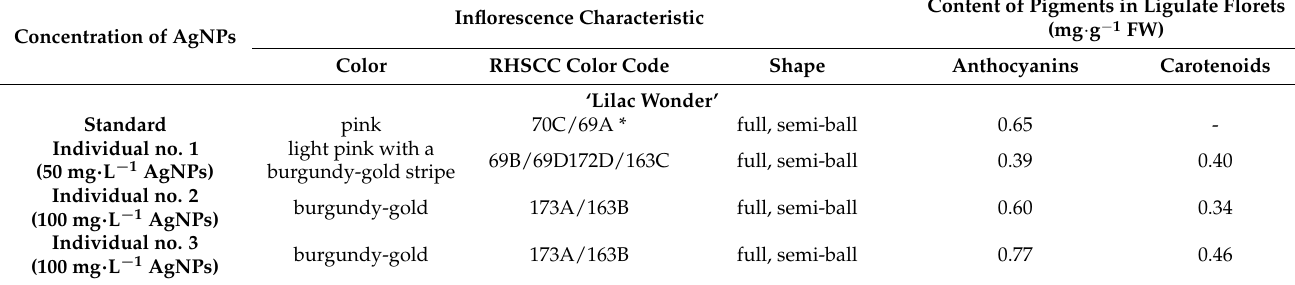
Table 3. Inflorescence characteristics, composition, and content of pigments in ligulate florets of Chrysanthemum × grandiflorum ‘Lilac Wonder’ and ‘Richmond’, and their mutants, depending on the AgNPs treatment (0–100 mg · L − 1